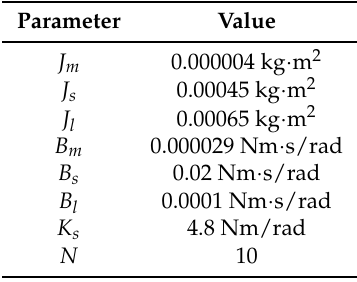
Table 6. Simulation parameters of SEA